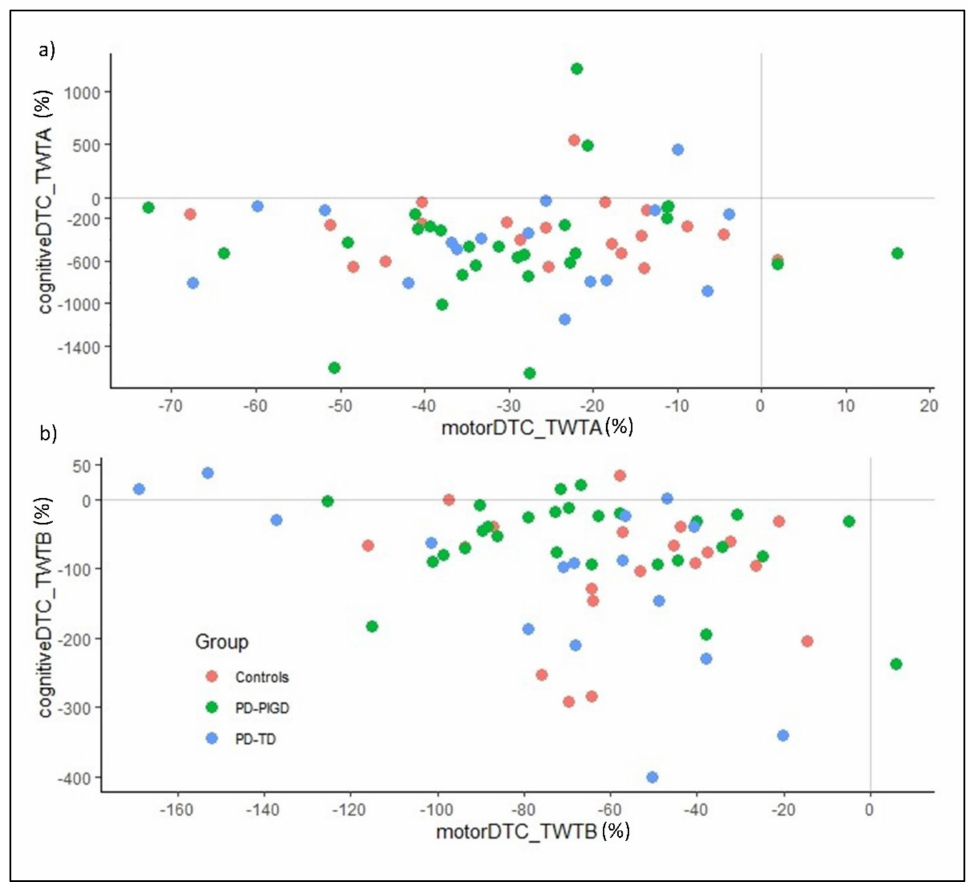
Figure 2. ( a ) Pattern of motor-cognitive DTC in TWT-A based on times in PIGD, TD, and control. ( b ) Pattern of motor-cognitive DTC in TWT-B based on times in PIGD, TD, and control. Motor and cognitive DTCs are calculated using the following formula: DTC (%) = ((performance DT − performance in ST)/performance in ST) ×